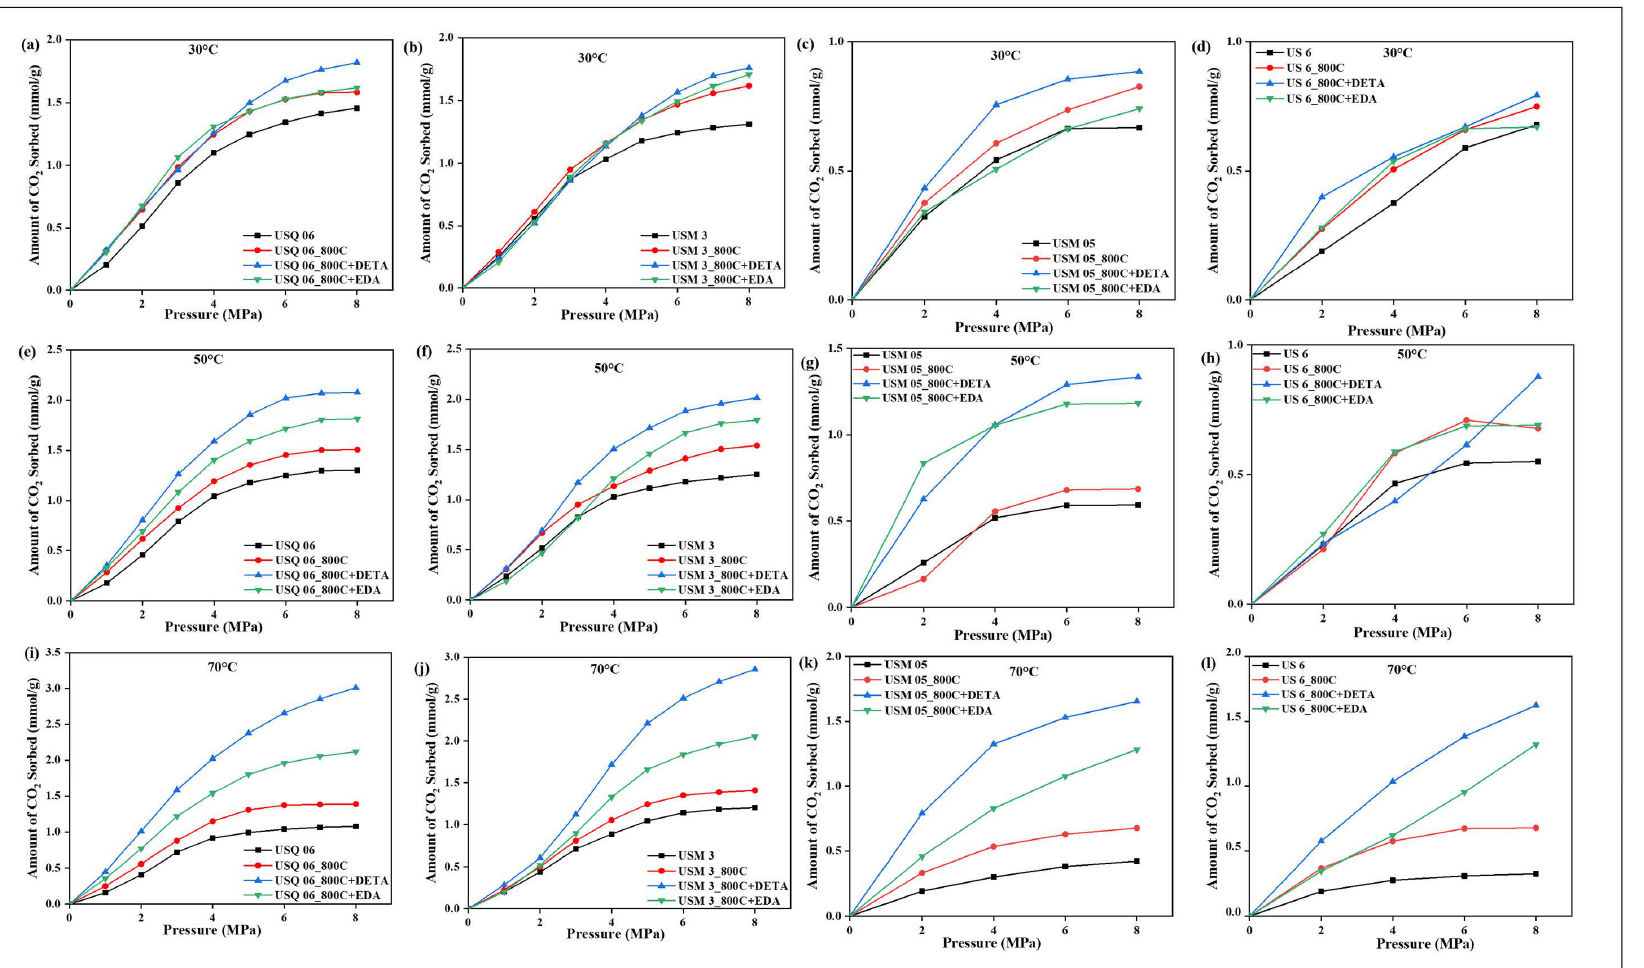
Figure 8. Amount of CO 2 sorbed relative to the pyrolysis and amine treatments at temperatures 30 ◦ C ( a – d ), 50 ◦ C ( e – h ), 70 ◦ C ( i – l ), and up to 8 MPa